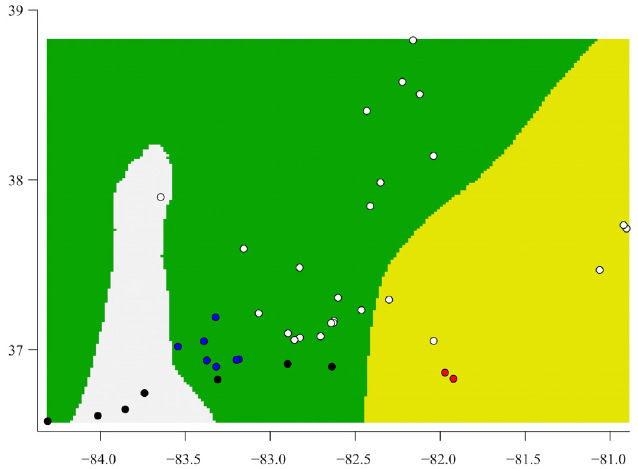
Fig 6. Geneland results, with grouping inferred from nuclear loci. The three colors correspond to the three groups inferred by Geneland. The dots are the collecting localities (see Fig 1), and are colored by clade: white = Clade A; blue = Clade B; red = Clade C; black = Clade D. The histogram shows the log of the ratio of the estimates rates of coalescence and the estimated Yule rates. Values above zero indicate the estimated rate of coalescence is